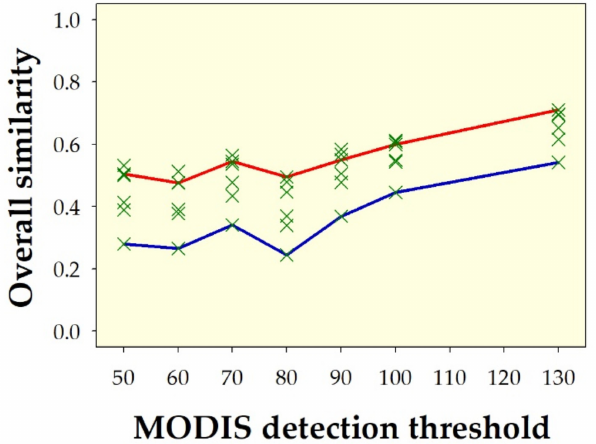
Figure 17. Overall similarity (i.e., the average of similarity of θ and similarity of δ ) of temporal pattern between deforestation hotspots in Indonesia in 2020, derived from Landsat-8 OLI at clarity ≥ 50% and deforestation intensity ≥ 50%, and deforestation hotspots in Indonesia in 2020, derived from MODIS at change-detection thresholds ranging from 50 to 130. Green crosses indicate overall similarity from all nine metrics. Red lines on the upper edge of the envelopes indicate overall similarity using metric of Fidelity. Blue lines on the upper edge of the envelopes indicate overall similarity using metric of